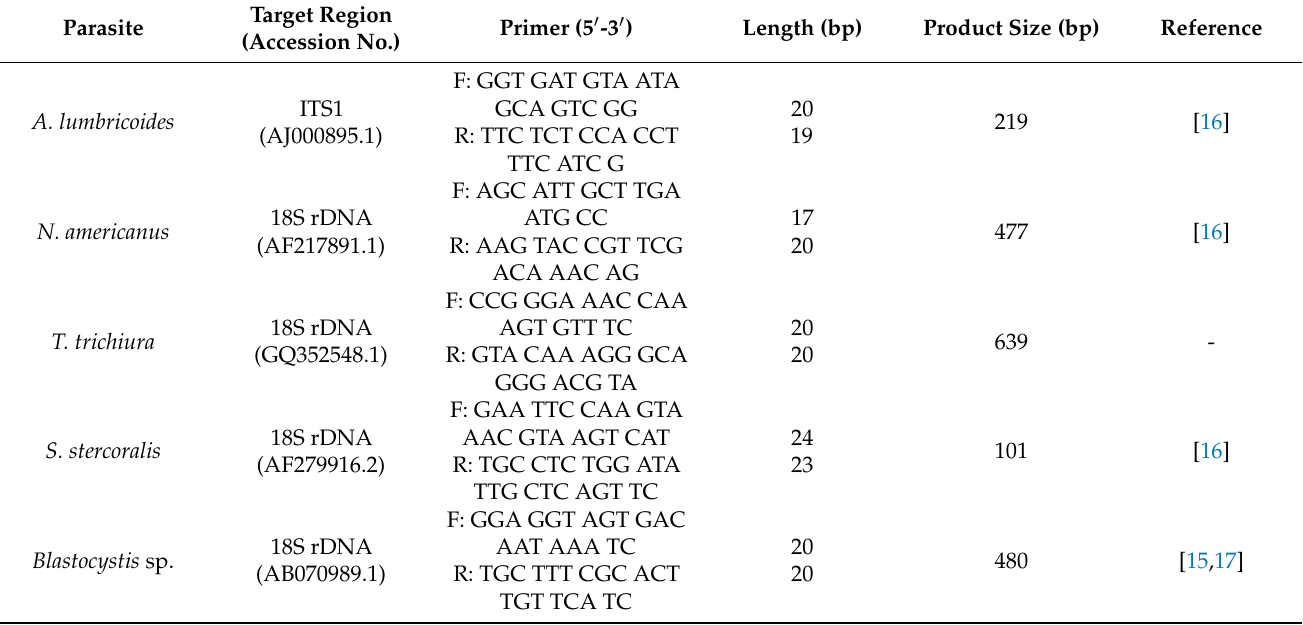
Table 1. Sequences for primers for detections of Ascaris lumbricoides , Necator americanus , Trichuris trichiura , Strongyloides stercoralis , and Blastocystis sp. by PCR. F: Forward, R: